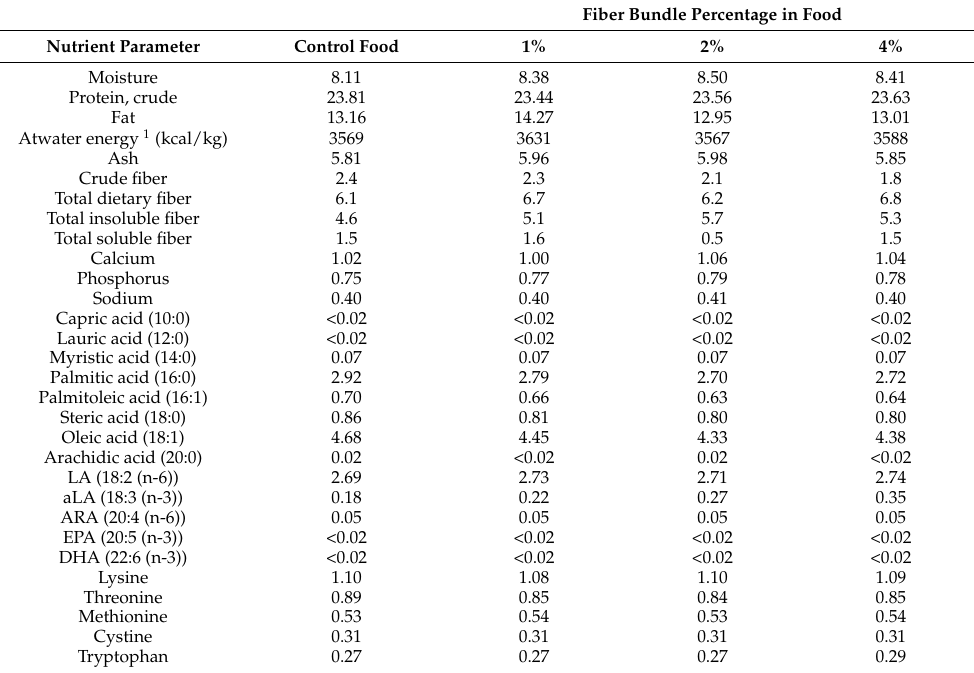
Table 1. Composition of test foods containing 0, 1, 2, or 4% added fiber-bound polyphenol ingredients (grams/100 grams as mixed or as fed, unless otherwise stated).